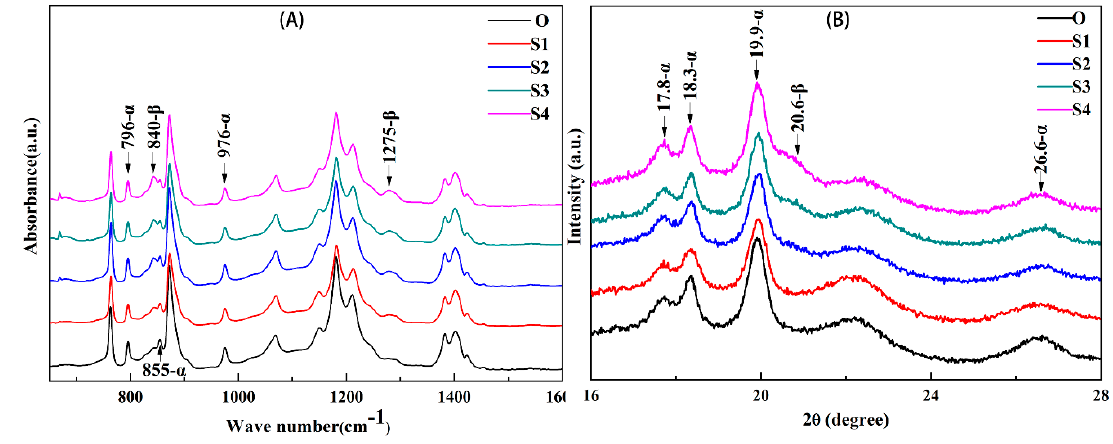
Figure 1. The attenuated total reflectance-Fourier transform infrared (ATR-FTIR) spectra ( A ) and X-ray diffractograms ( B ) of the membrane samples stretched with different stretching ratios.